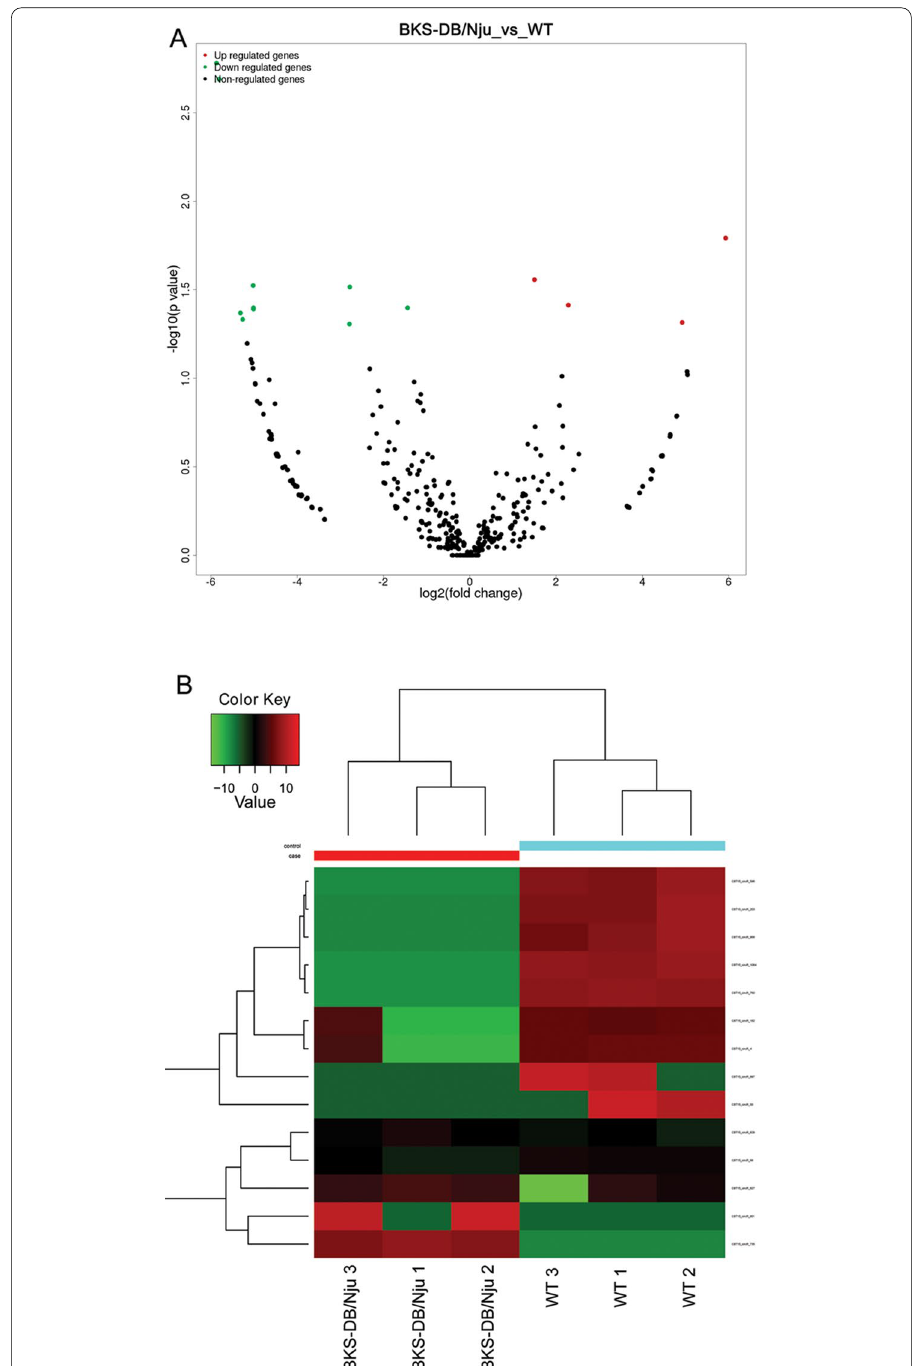
Fig. 2 Differential expression analysis of circular RNAs (circRNAs). A Volcano plot. Red dots represent upregulated differential circRNAs, green dots represent downregulated differential circRNAs, and black dots represent circRNAs with no significant difference. B Hierarchical cluster analysis showing the 14 differentially expressed